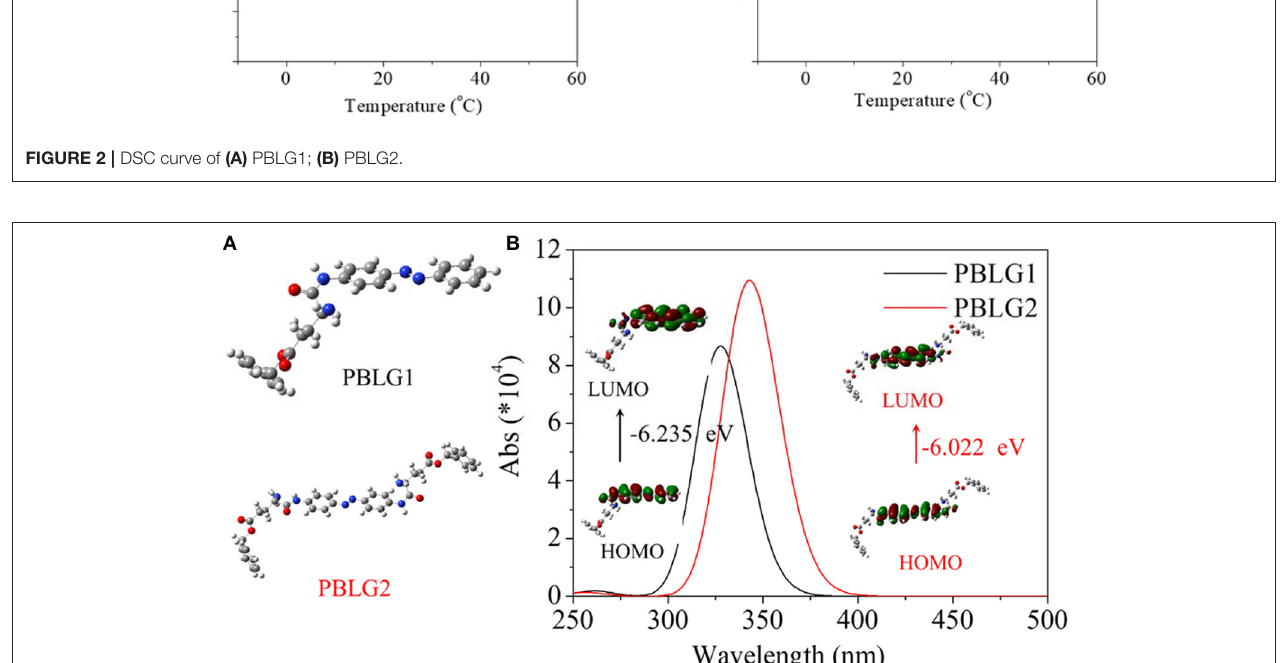
FIGURE 3 | (A) Calculated models for PBLG1 and PBLG2; (B) Calculated UV-vis spectra and the corresponding molecular orbital transitions from HOMO to LUMO of two different models. The energy gap is illustrated in the